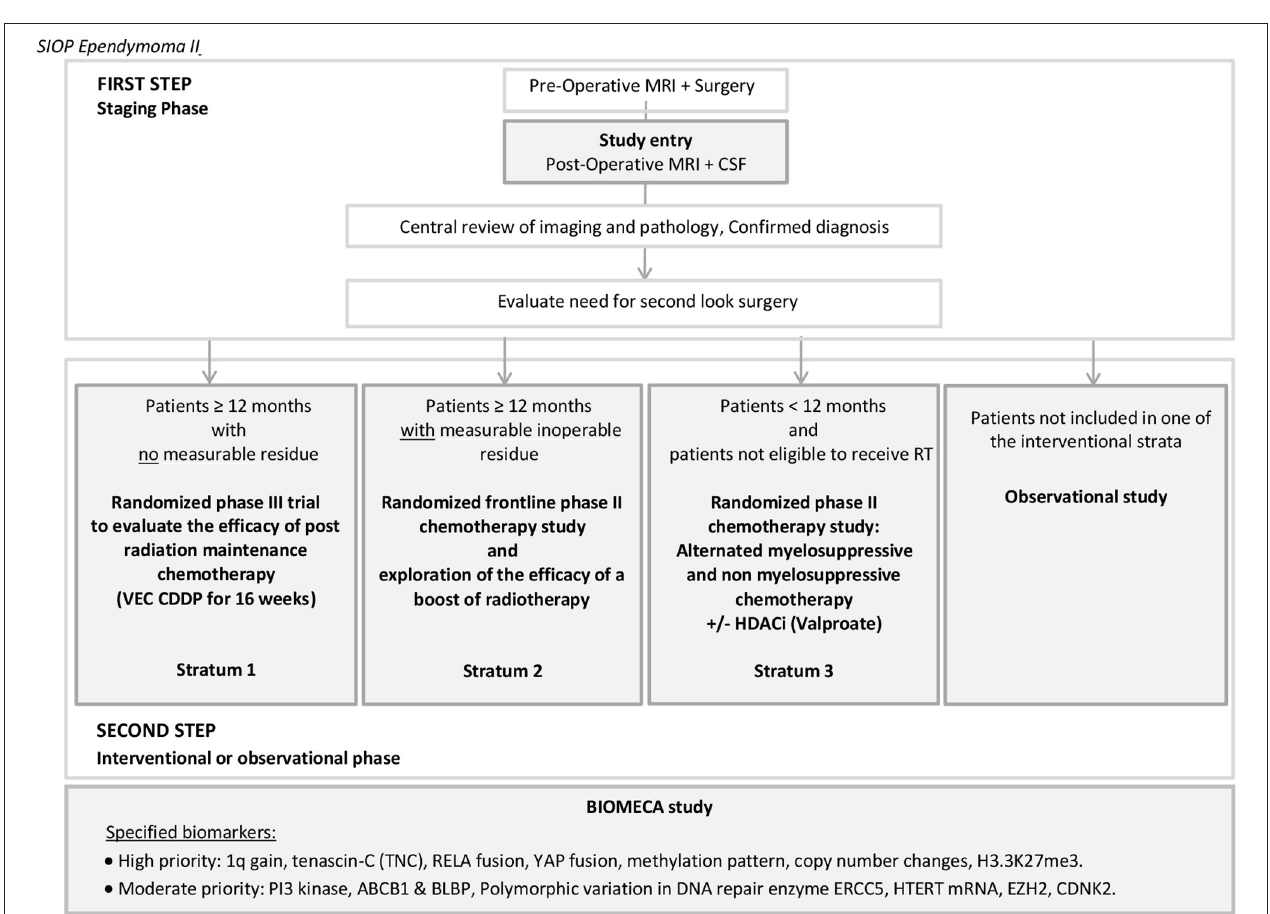
FIGURE 1 | General scheme of the SIOP EPII trial. BIOMECA: Biomarkers of Ependymomas in Children and